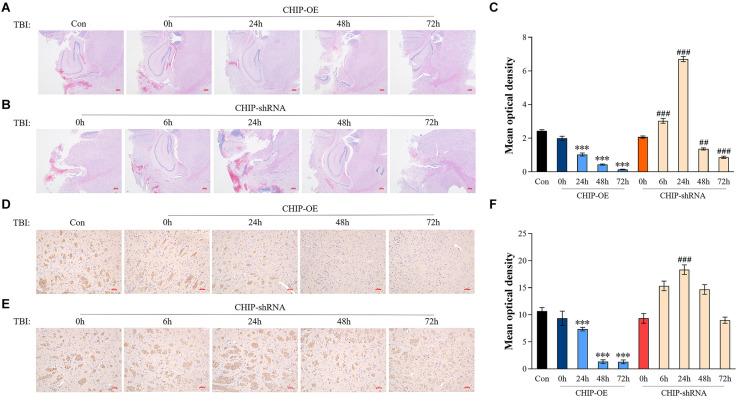
Hematoxylin and eosin (HE) staining and blood–brain barrier permeability evaluation after in vivo traumatic brain injury. (A) HE staining (40×) in pericontusional cortex at 0, 24, 48, and 72 h after CCI in CHIP-OE group. (B) HE staining (40×) in pericontusional cortex at 0, 6, 24, 48, and 72 h after CCI in CHIP-shRNA group. (C) Semi-quantified analysis of hemorrhagic injury (red stained areas) using mean OD. CHIP-OE 24, 48, and 72 h vs. CHIP-OE-0h, ∗∗∗p < 0.001; CHIP-shRNA 6, 24, 48, and 72 h vs. CHIP-shRNA-0 h, ##p < 0.01, ###p < 0.001. (D) Immunohistochemical staining (200×) of IgG leakage in pericontusional regions at 0, 24, 48, and 72 h after CCI in CHIP-OE group. (E) Immunohistochemical staining (200×) of IgG leakage in pericontusional regions at 0, 6, 24, 48, and 72 h after CCI in CHIP-shRNA group. (F) Semi-quantitative analysis of leaked IgG protein using mean OD. CHIP-OE 24, 48, and 72 h vs. CHIP-OE-0h, ∗∗∗p < 0.001; CHIP-shRNA 6, 24, 48, and 72 h vs. CHIP-shRNA-0 h, ###p < 0.001. Scale bars in (A,B) were 200 μm and, in (D,E), were 50 μm.